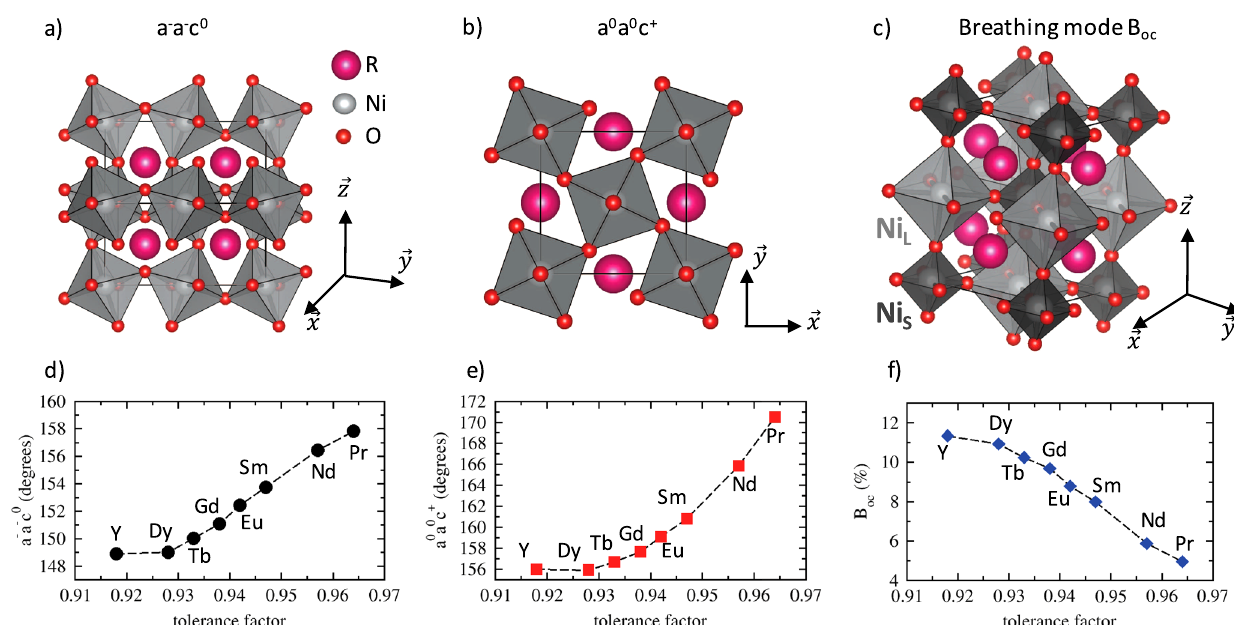
Fig. 2 Rare-earth nickelates ground state structural properties. a , b and c Schematic pictures of the three main lattice distortions appearing in the ground state of nickelates: a − a − c 0 AFD motion, a 0 a 0 c + AFD motion and breathing of the oxygen cage octahedra B oc . d , e Ni – O – Ni angle (in degrees) produced by the a − a − c 0 and a 0 a 0 c + AFD motions. f Oxygen cage octahedra volume expansion/contraction (in %) produced by the breathing mode